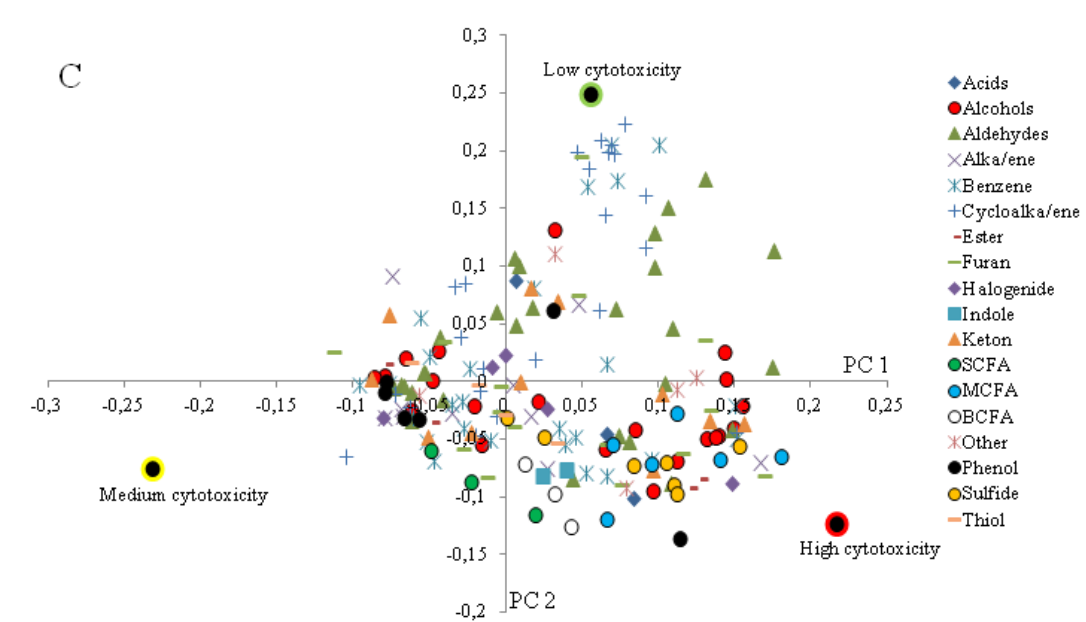
Figure 7. ( A ) Results of multivariate analysis of fecal metabolite profiles colored according to cytotoxicity and ( B ) colored according to lactose-digestibility status (LM-IT, LM-T and NLD). Relative indices of the metabolites detected in the fecal samples collected by LM-IT, LM-T and NLD at baseline were used for a supervised clustering analysis by a partial least squares-discriminant analysis according to cytotoxicity; ( C ) The resulting loadings for principal components (PC) 1 and 2 are shown. LM-IT: lactose malabsorption with abdominal complaints; LM-T: lactose malabsorption with without abdominal complaints.